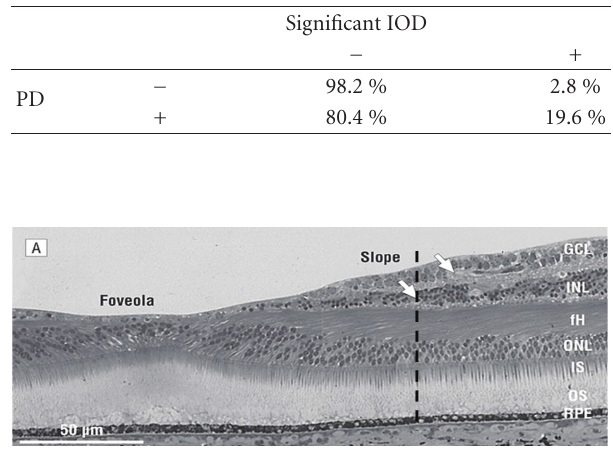
Figure 3: This shows histology of the human retina (after Provis and Hendrickson). Interrupted lines represent perifoveolar radial distances of 0.9 and 1.25 mm where ganglion cells begin to dom- inate inner retinal thickness. Maximal IA occurs at distances less than 0.9 mm [22].